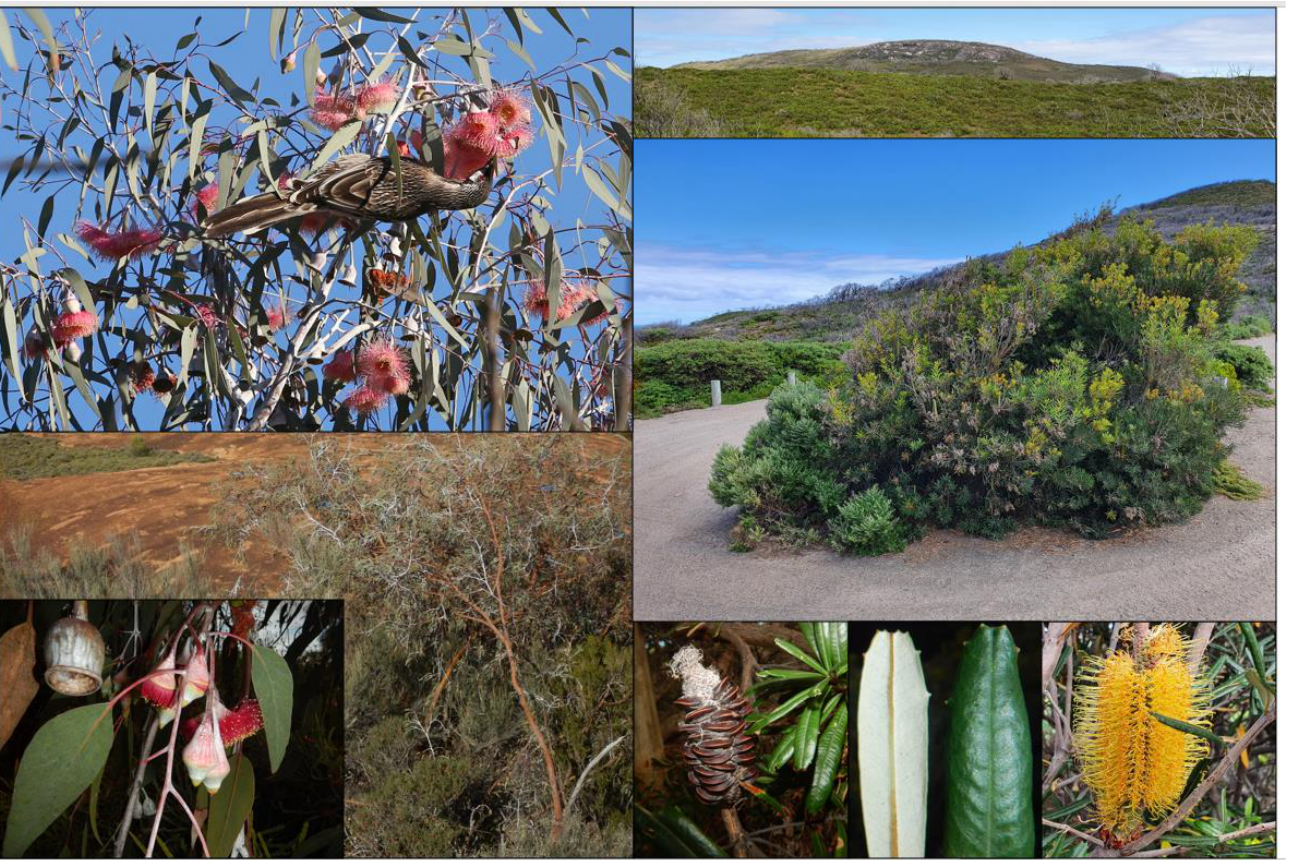
Figure 3. Two examples of narrow endemics from the SWAFR whose biological attributes and gran- ite outcrop habitats occupied meet those predicted by OCBIL theory. Left: Eucalyptus caesia (Myrtaceae) and right: Banksia seminuda subsp. remanens (Proteaceae). Photos S.D. Hopper, Keith Lightbody (top left), and Tim Robins (bottom right).